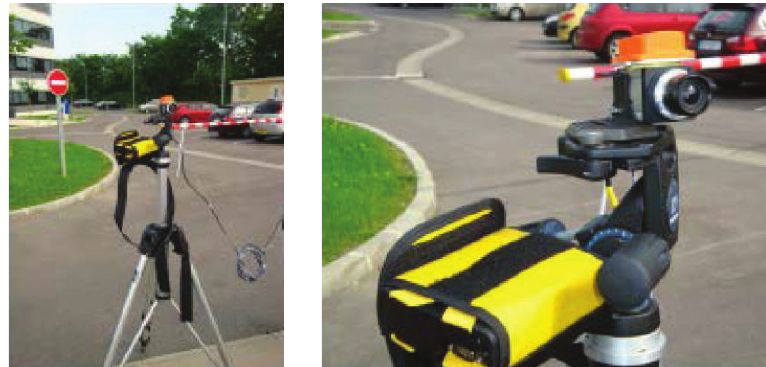
Figure 11: Our hybrid sensor mounted on a tripod.